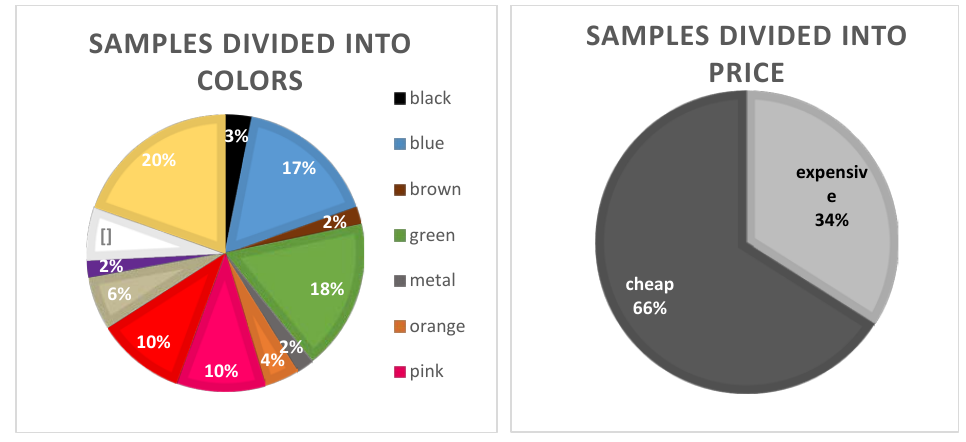
Figure 2. Samples divided into factors: colors and price.